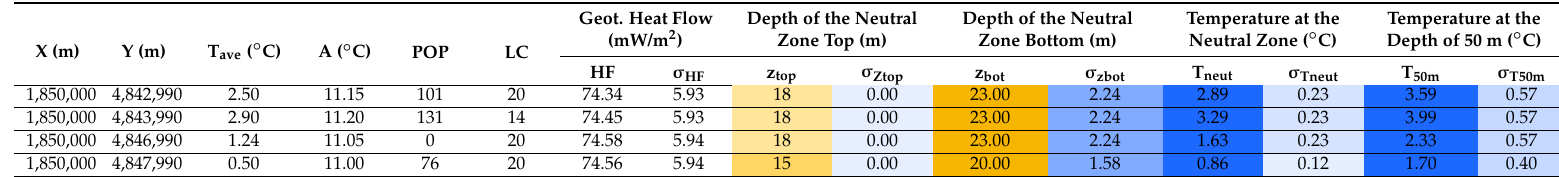
Table 11. Database of data used to define ground temperature evolution—second part (example grid nodes located in Andorra; colours of results cells compliant with colours used in Figures 4–7—see online